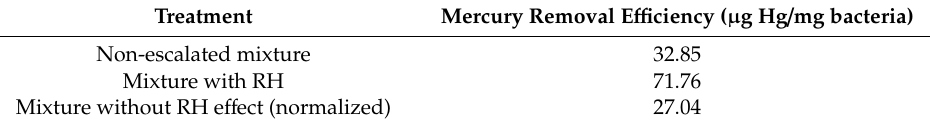
Table 3. Mercury removal e ffi ciency comparison of free cells (after 1 h) vs. escalated process.